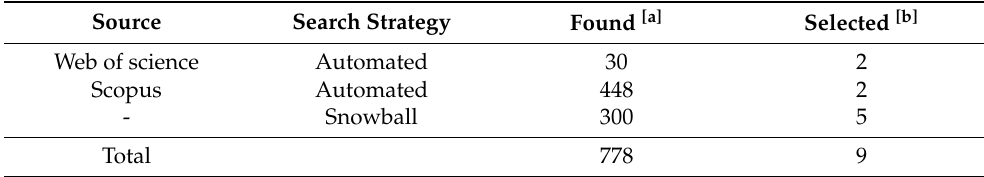
Table 2. Search results and study